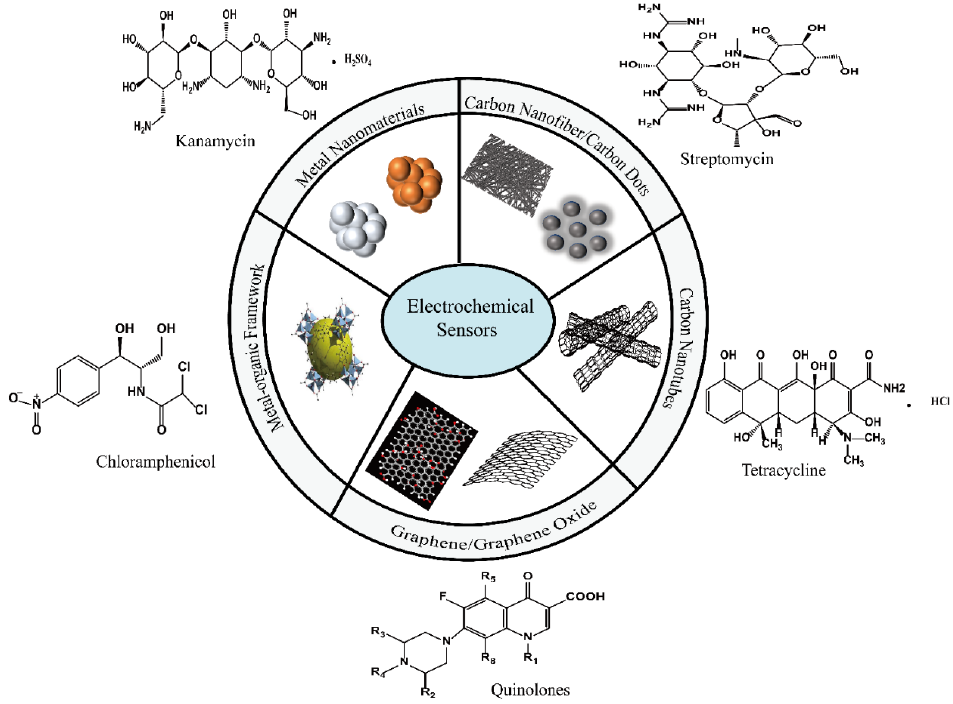
Figure 2. Nanomaterials for electrochemical method of antibiotic.